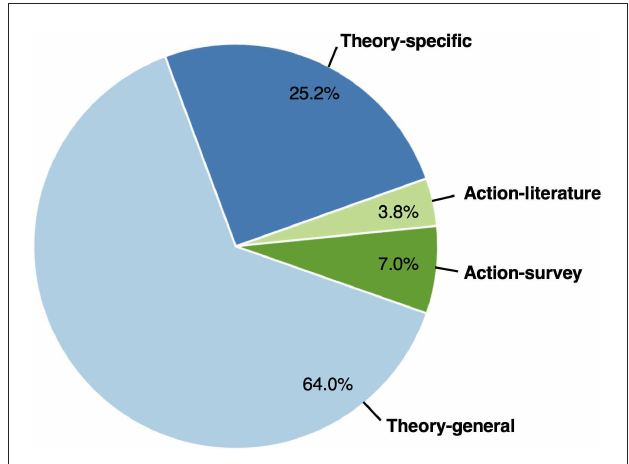
FIGURE1 Proportion of documented implementation categories for n = 444 articles coded as action, theory with a specific recommendation, and theory without a specific